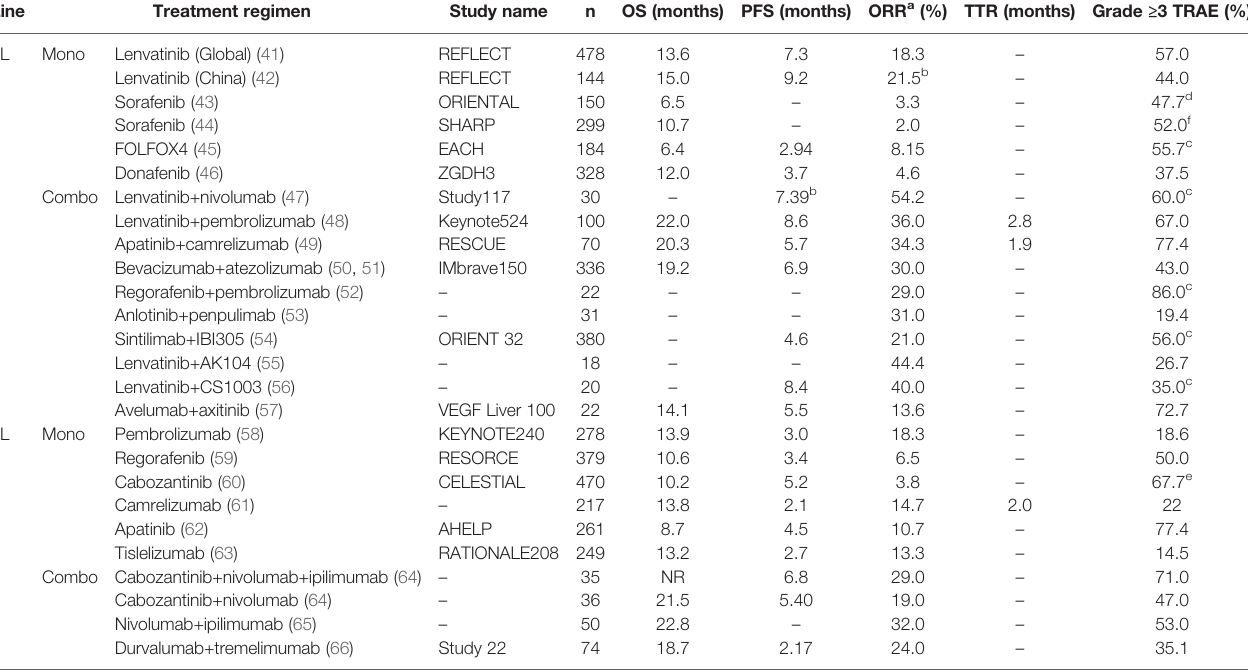
TABLE 2 | Summary of ef fi cacy data of systematic treatments for advanced HCC.